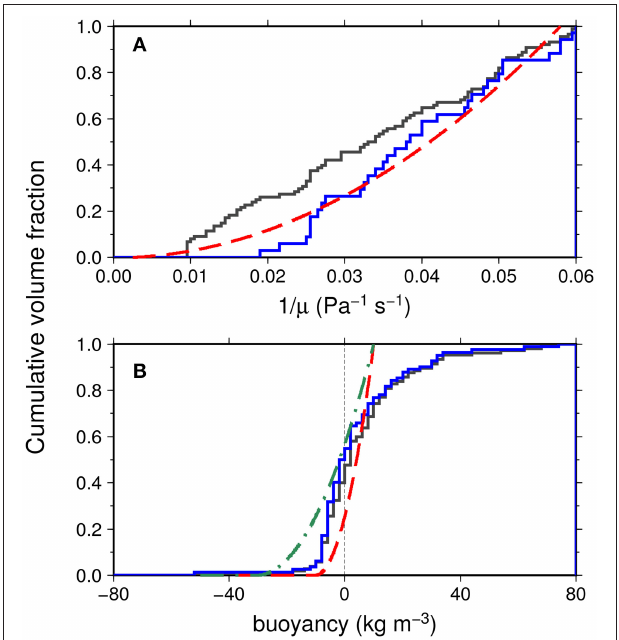
FIGURE 4 | Comparison of sill model predictions and observed relationship between erupted volume and magmatic density and viscosity. (A) Cumulative histogram of the relationship between inverse viscosity and fraction of total erupted volume. The black continuous line shows all observations from the NVZ. The blue line shows NVZ samples with density under 2,720 kg m − 3 . The predicted relationship between magma viscosity and maximum melt flux rate is shown as a dashed red curve. This curve was calculated only for magma with the viscosity range in samples with densities under 2,720 kg m − 3 . The density of the model magma was held constant at 2,710 kg m − 3 for these calculations. (B) Cumulative histogram showing the relationship between erupted volume fraction and sample density, relative to a reference density of 2,710 kg m − 3 . The black continuous line shows all observations from the NVZ; the blue line shows samples with viscosity under 50 Pa s. The model results shown as a dashed red curve were calculated for the density range found in melts with viscosity under 50 Pa s. The viscosity of the model magma was held constant at 50 Pa s for these calculations. For both plots, the red curves are calculated using the following reference values: G = 10 GPa; h = 10 km; P f = 1 MPa. The green dashed curve in (B) shows the effect of changing the reference values to G = 75 GPa and P f = 3 MPa.